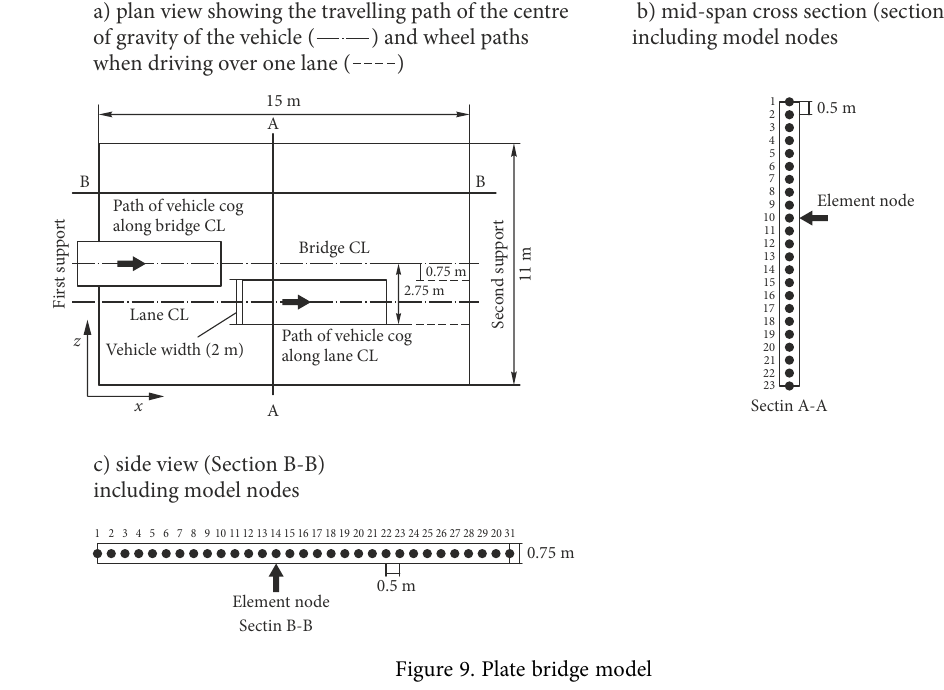
Figure 9. Plate bridge